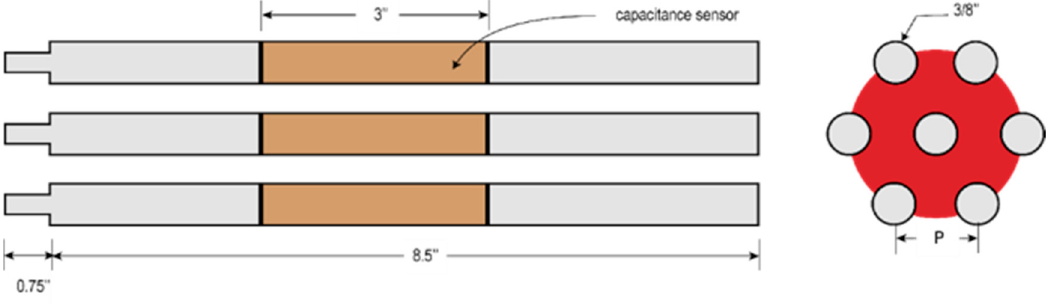
Figure 5. The sensor geometrical parameters.